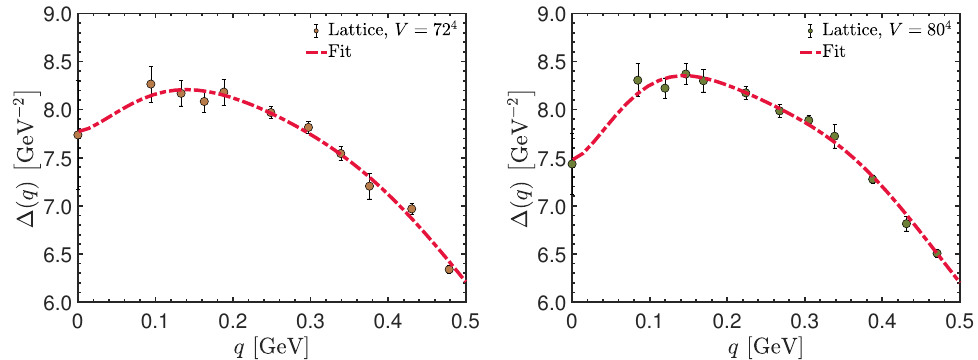
Figure 15. Lattice data for the gluon propagator in the deep infrared. The data displayed correspond to the two lattice setups with the largest volumes of [49], namely, V = 72 4 ( left ) and V = 80 4 ( right ). The red dashed lines are smooth fits from which the position of the maximum can be